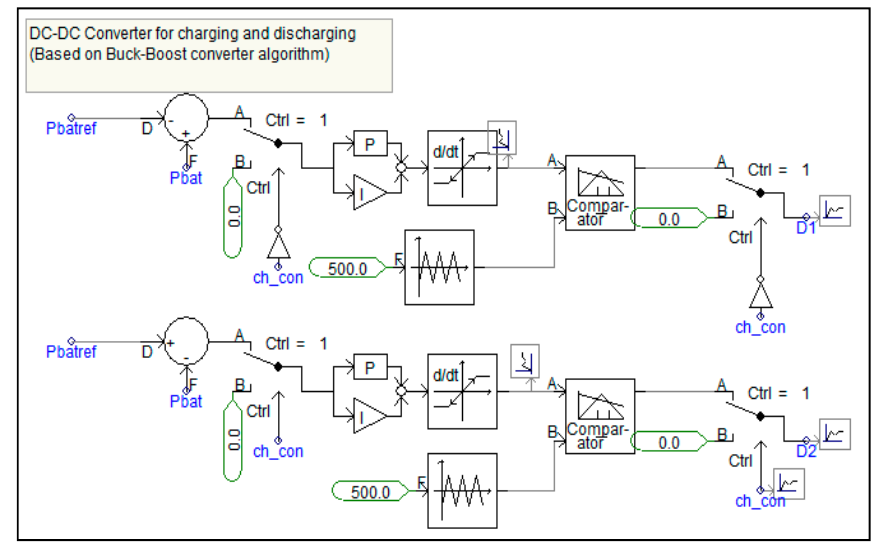
Figure 31. Charge and discharge control in PSCAD.